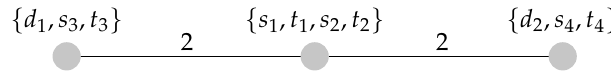
Figure 4. A worst-case instance of the MA ( 2, µ ) for CS lat , s = t